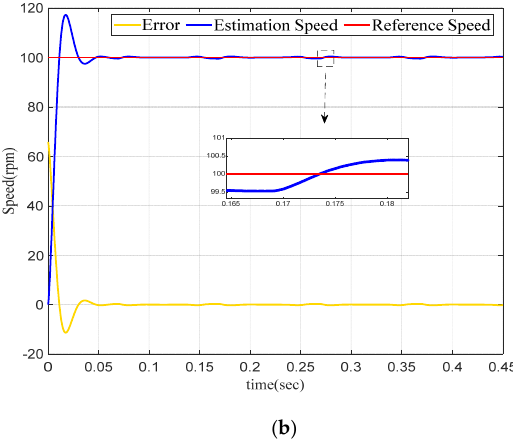
Figure 8. ( a ) Normal PID control+MRAO, ( b ) FOMRAC+MRAO.